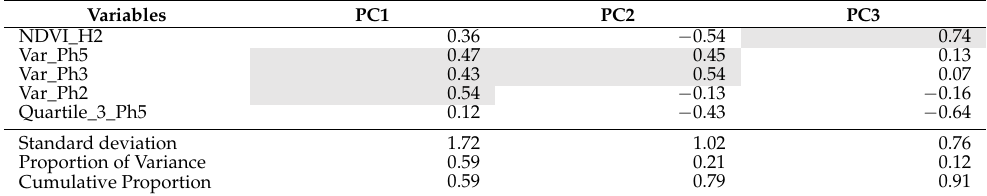
Table A2. After removing the variables with a strong correlation for the summary statistics with the least explanatory power, the first principal components from the PCA for the selected variables are shown. Those variables with higher explanatory power for each principal component are highlighted.